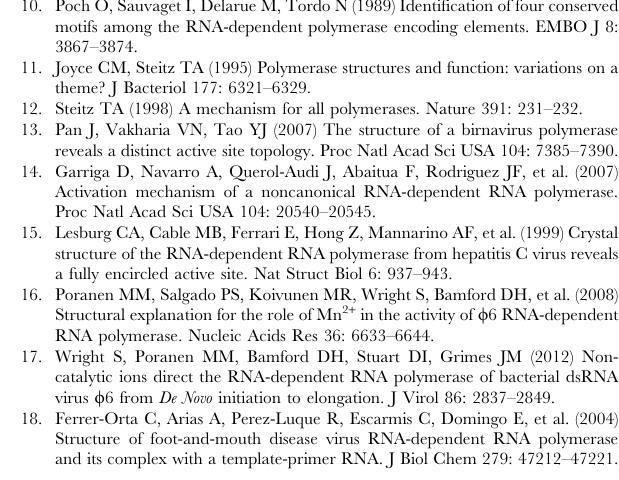
Figure S1 The geometrical constraints for the identification of hand-shaped polymerase structures with bound non-catalytic ions.